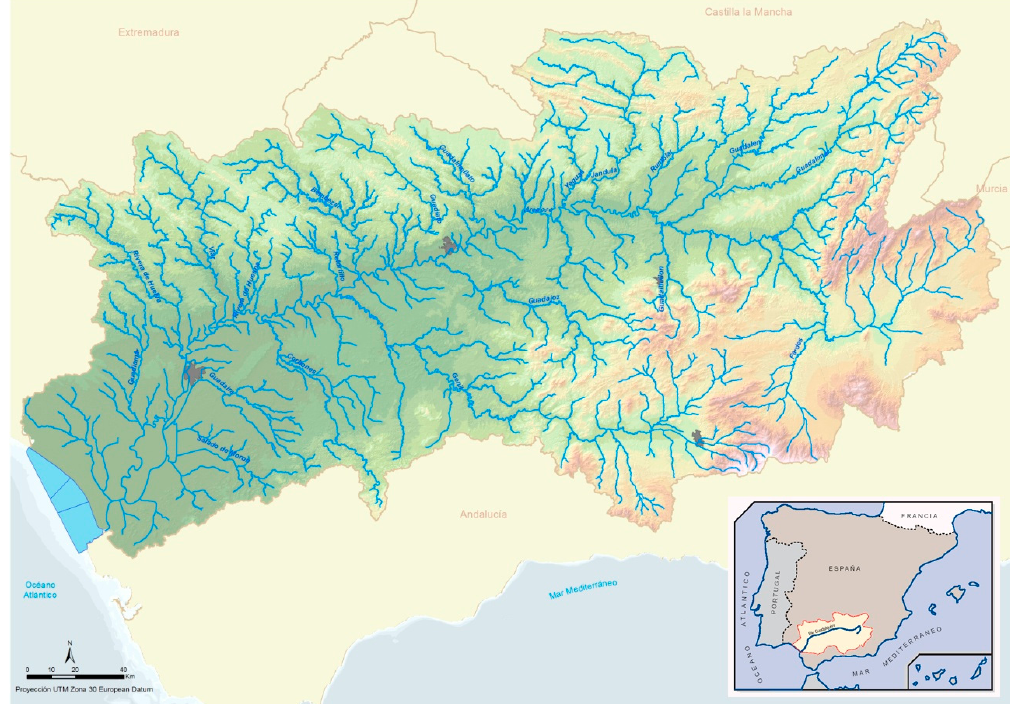
Figure 1. Guadalquivir River Basin map. (Source: Adapted from the Guadalquivir River Basin Authority, www.chguadalquivir.es).